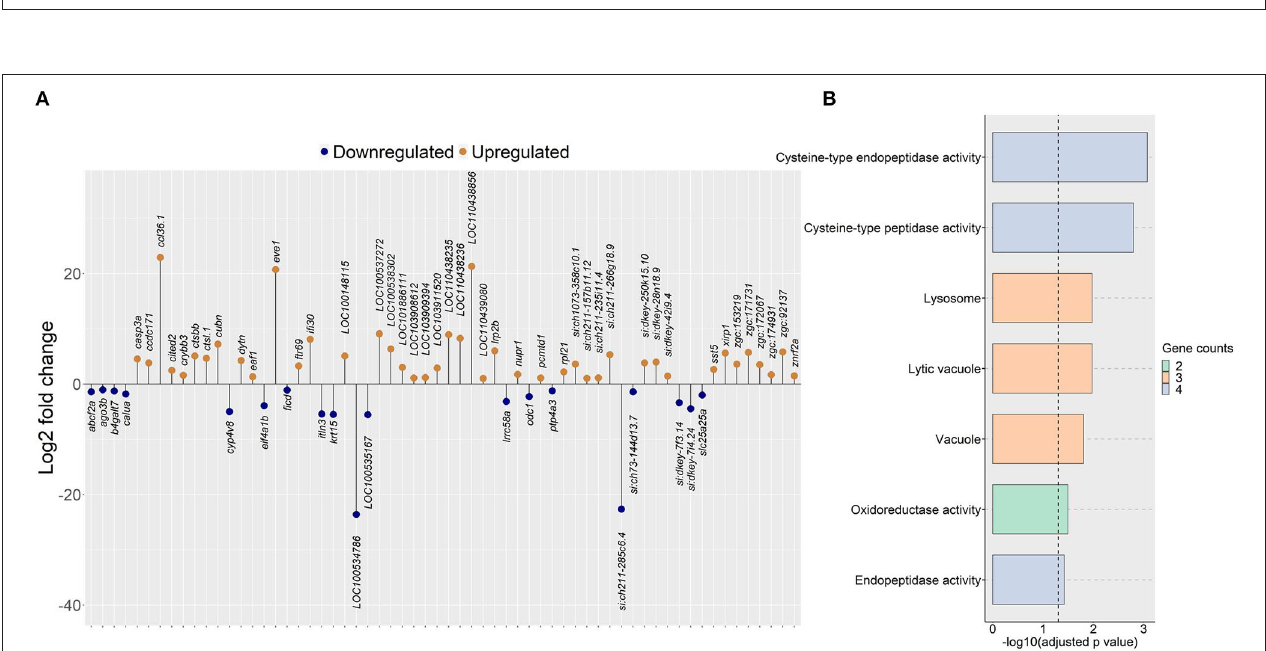
FIGURE 5 | Genes and GO terms that were regulated in zebrafish fed the algal glucan diet. (A) Differentially expressed genes obtained by comparing the algal glucan group (AG) with the high cholesterol (HC) group (|Log2 fold-change| ≥ 1, q -value < 0.05). (B) Bar plot showing enriched GO terms in the AG group, based on genes that were upregulated in the AG group compared to the HC group. Bar colors represent the gene count. For both analyses, each treatment group consisted of at least five biological replicates.